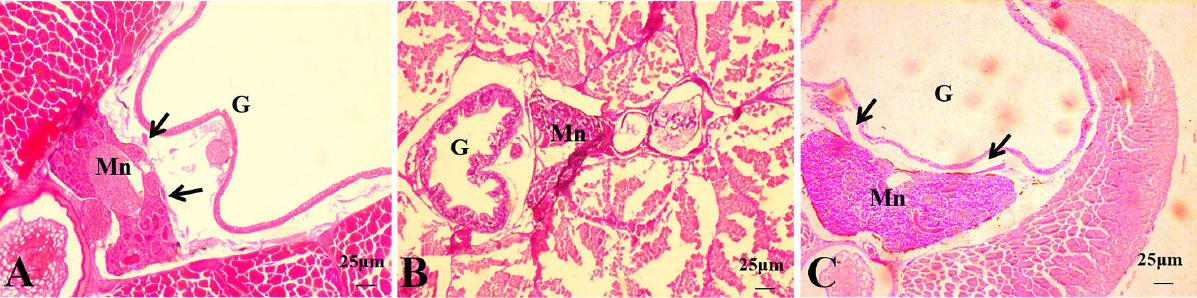
Figure 5. Histological images of gonads of loaches at 50 dph. ( A ) diploid loach; ( B ) hybrid triploid loach without gonads; ( C ) hybrid triploid loach; G: digestive tract; Mn: middle kidney.